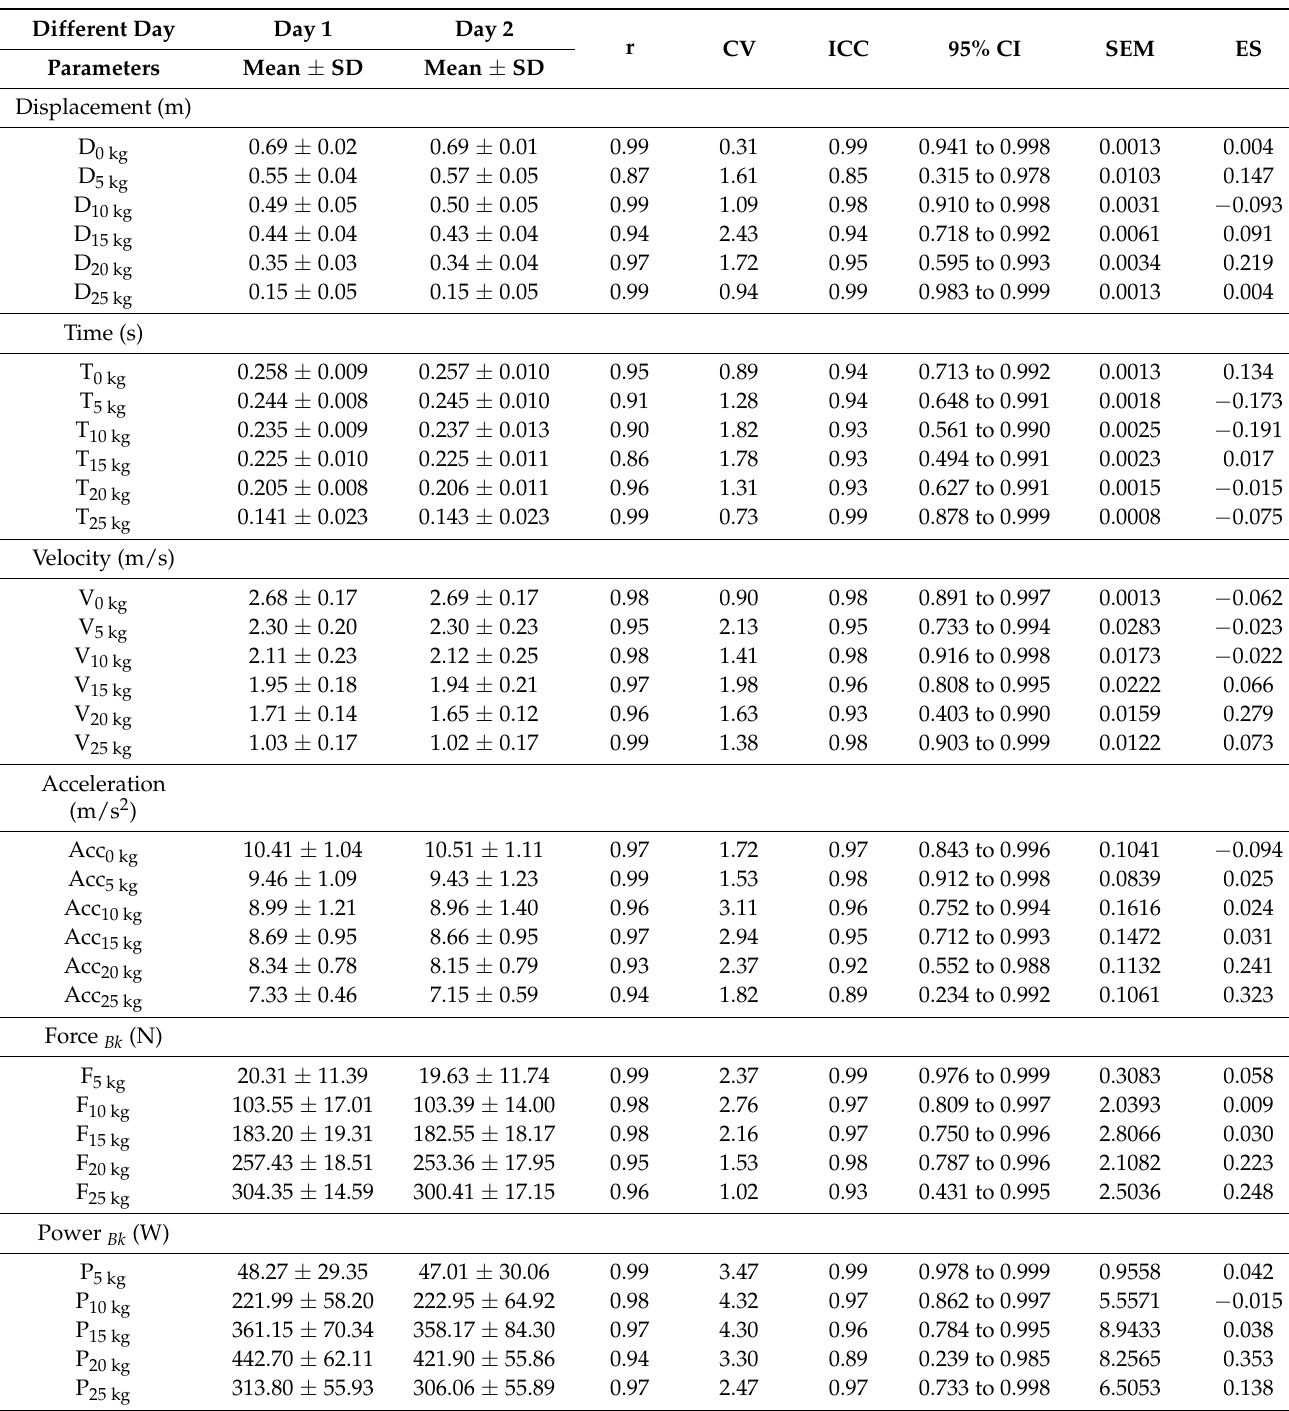
Table 1. Day-to-day repeatability of average displacement (m), time (s), velocity (m/s) and acceleration (m/s 2 ), force and power ± Standard Deviation (SD) of the vertical thrust exercise (in water) performed by 14 water polo players with increasing loads, r Pearson correlation coefficient; CV, Coefficient of Variation for repeated measurements; ICC, Interclass Correlation Coefficient; 95% Confidence Interval (CI); SEM, Standard Error of Measurement; and ES, Effect Size, for each